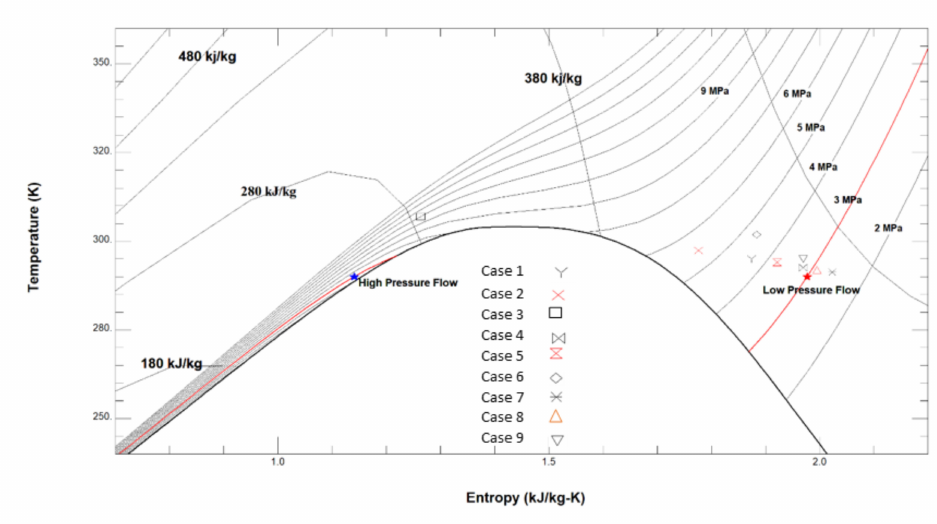
Figure 8. Location of outlet flow state on the temperature-entropy ( T - S )